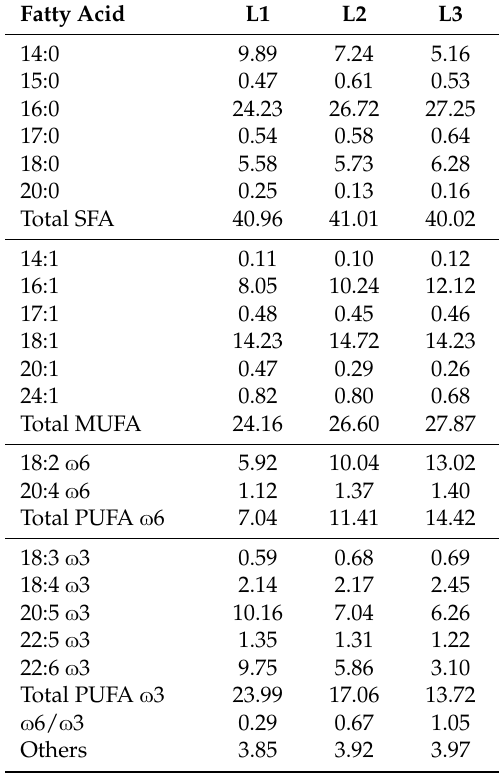
Table 4. Fatty acid profile of the three diets (% of total fatty